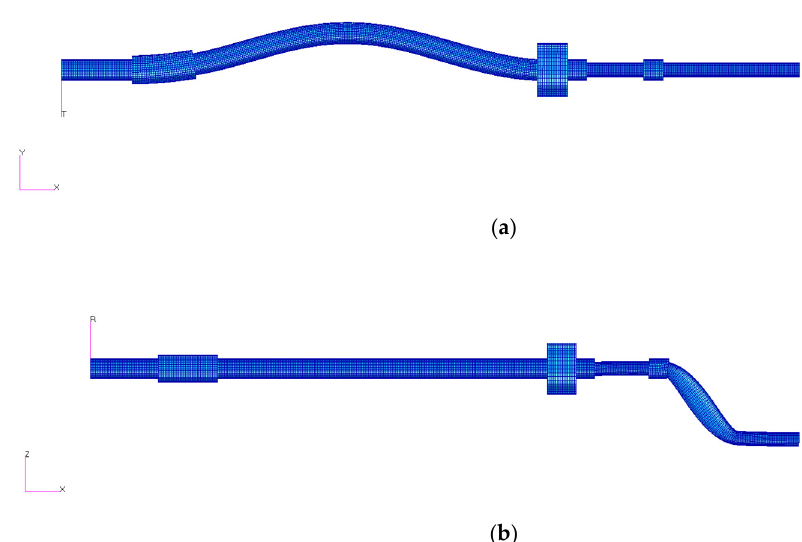
Figure 17. Shaft bending mode. ( a ) 1st mode, ( b ) 3rd mode.